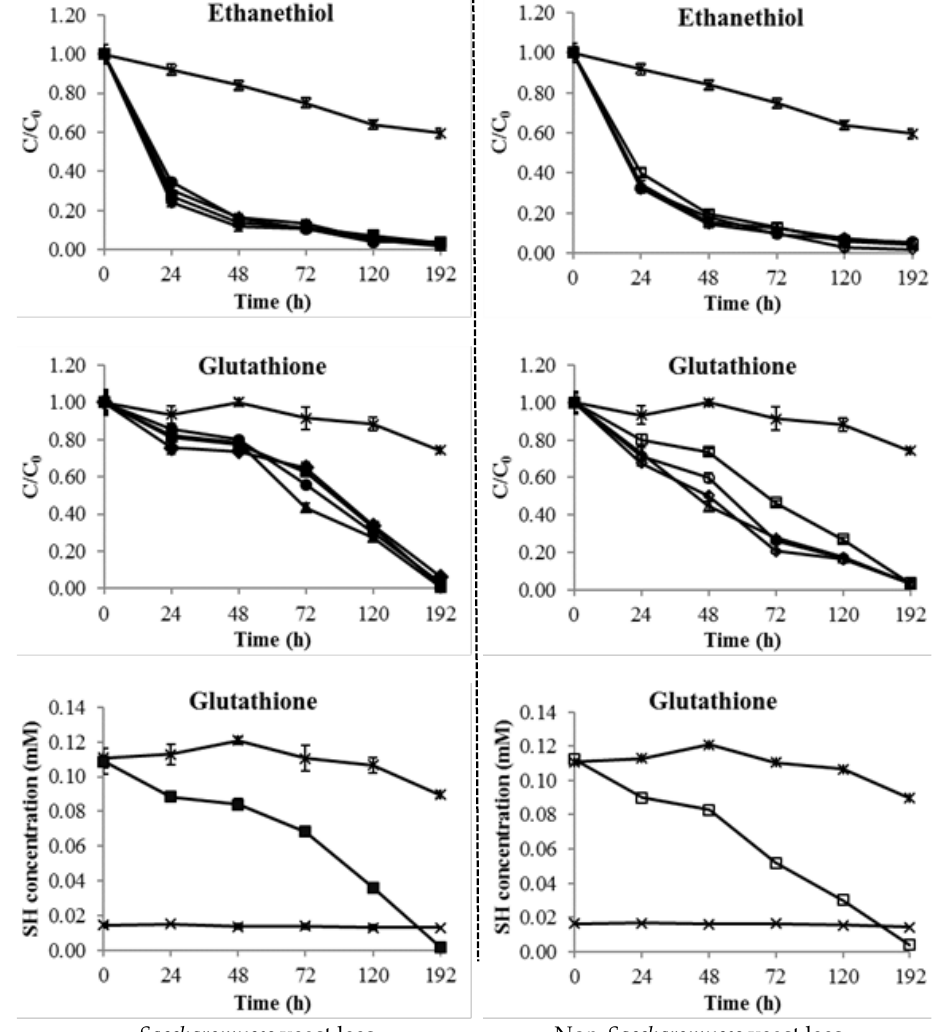
Figure 4. Thiols (ethanethiol and glutathione) consumption by eight types of yeast lees. Thiol control (ж), S. cerevisiae EC-1118 ( ■ ), S. cerevisiae Merit ( ▲ ), S. cerevisiae R2 (●), S. cerevisiae 71B ( ◆ ), T. delbrueckii Biodiva (□), W. saturnus NCYC22 (Δ), L. thermotolerans Concerto ( ○ ), T. delbrueckii Prelude (◊), yeast lees control